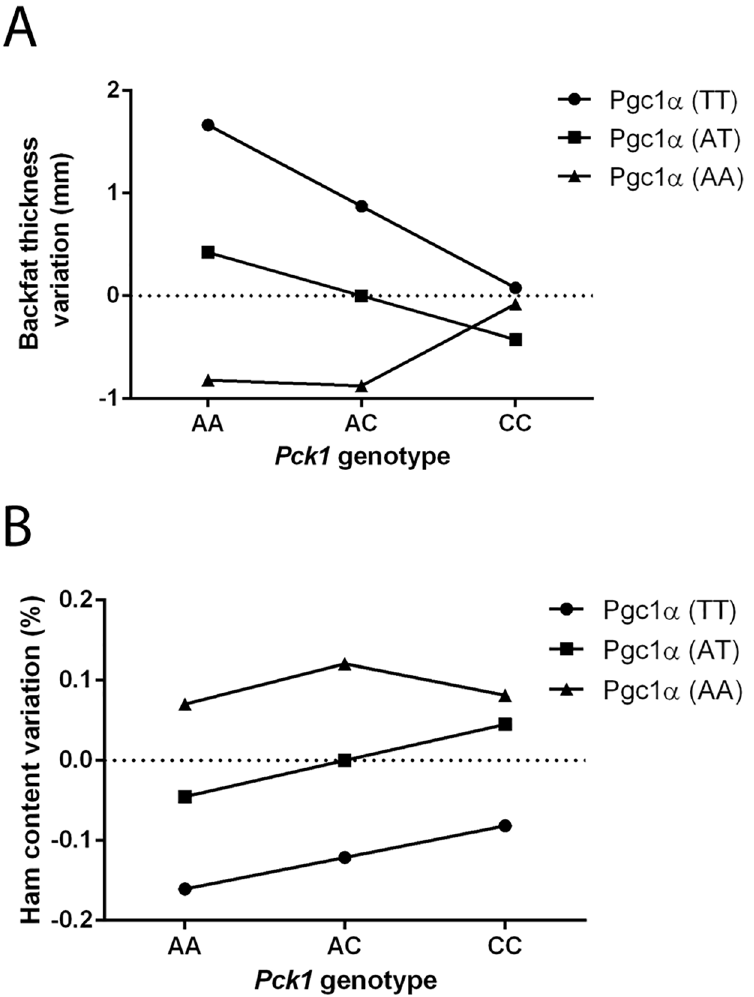
Fig 4. Epistasis between Pg1 α c.A1378Tand Pck1 c.A2456Cpolymorphisms. Graphicalrepresentation of epistatic effects from data presented in Table 1 for traits (A) backfat thickness and (B) ham content. The additiveeffect of locus Pgc1 α is greater in the Pck1AA background and disappears(backfat thickness variation) or is diminished (ham content variation) in the Pck1CC